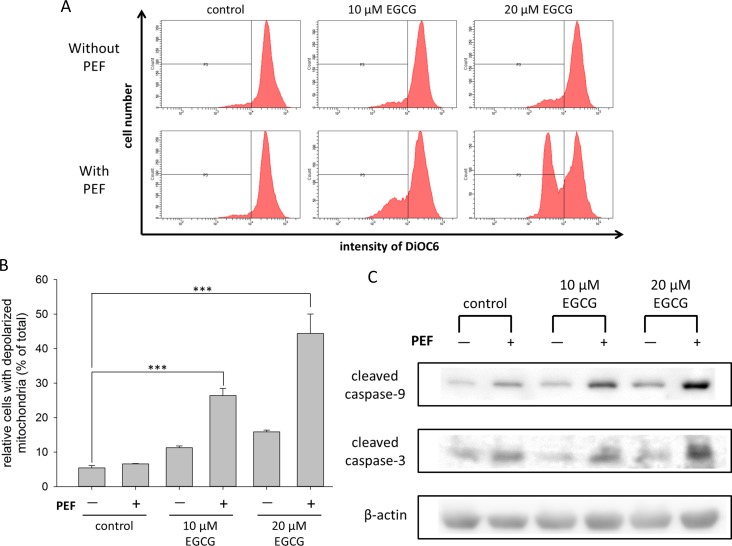
Effects of co-treatment with EGCG and PEF on mitochondrial-mediated apoptotic pathway.(A) The dissipation of mitochondrial membrane potential (MMP) was determined using DiOC6 staining. DiOC6 is a green-fluorescent and positively charged molecule that can accumulate in the polarized mitochondria, and the reduction of its fluorescence intensity indicated the depolarization of mitochondria. Our results showed the PEF could enhance the EGCG-induced MMP dissipation. (B) The percentage of cells with depolarized mitochondria was significantly increased when the PEF was applied to EGCG treatment. (C) Cleaved caspase-9 and -3 were detected by Western blot. β-actin was used as a loading control. This result showed that the EGCG-induced caspase activities were enhanced when cells were further exposed to the PEF. The “+” means that the PEF was involved in the treatment, and the “-” means the PEF was not involved.